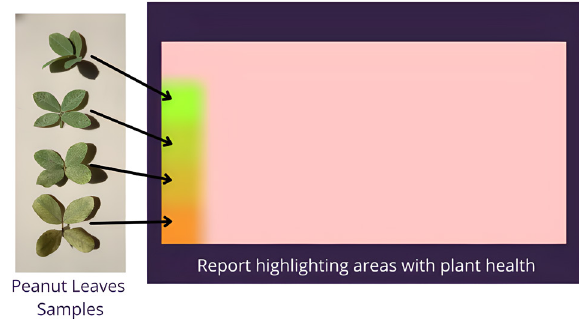
Figure 5. The Report generated by the system